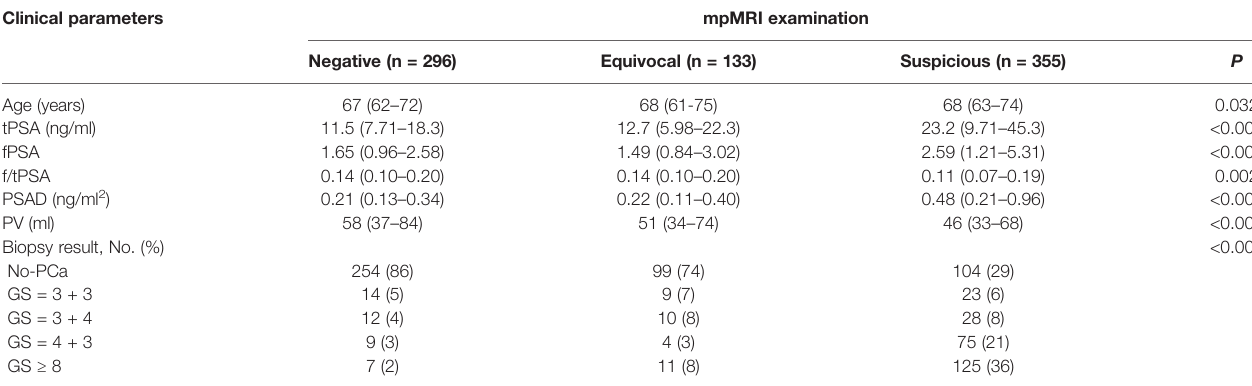
TABLE 1 | The clinical parameters and biopsy results by category of mpMRI results between April 2016 and March 2020. Clinical